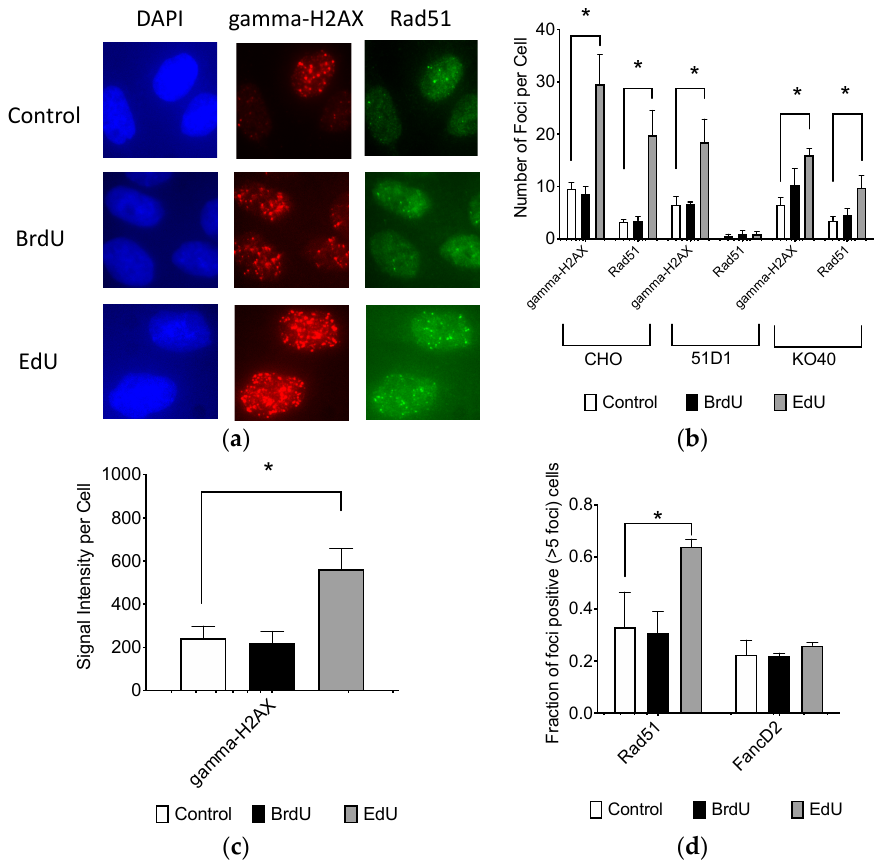
Figure 3. DNA damage and response after BrdU and EdU treatment. ( a ) Immunocytochemistry images after 10 μ M BrdU or EdU treatment visualized with DAPI (blue), gamma-H2AX (red) and Rad51 (green) for CHO cells; ( b ) quantitative DNA damage response analysis of 10 μ M BrdU or EdU treatment for CHO, 51D1, and KO40 cells; ( c ) signal intensity analysis of CHO cells; ( d ) populations of Rad51-positive (foci more than 5 per cell) cells after 10 μ M BrdU or EdU treatment for CHO cells. White bar indicates control. Black bar indicates BrdU treatment. Grey bar indicates EdU treatment. Error bars represent the standard error of the mean of three independent experiments. One-way ANOVA, Dunnett’s Multiple Comparison Test was performed to provide p -values. * indicates statistically significant di ff erences ( p <